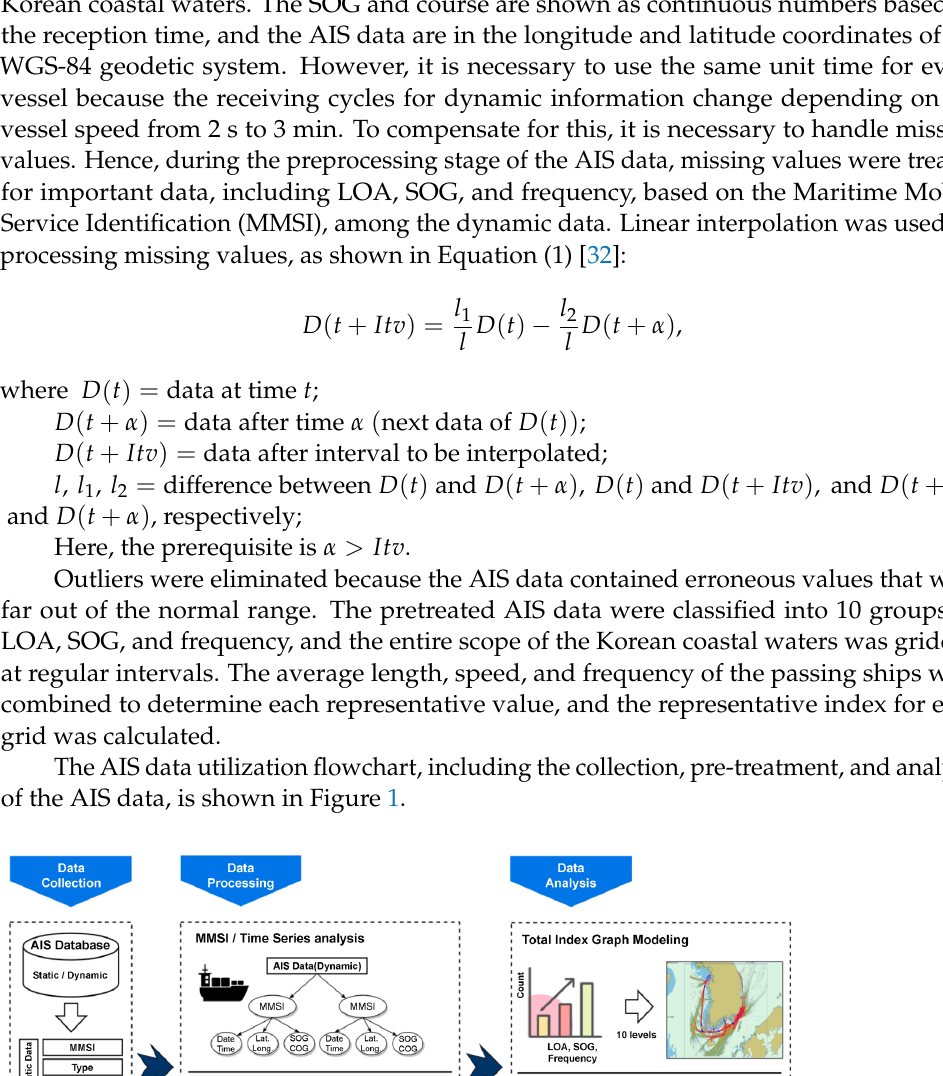
Table 1. Analysis period and range of AIS data. AIS Data